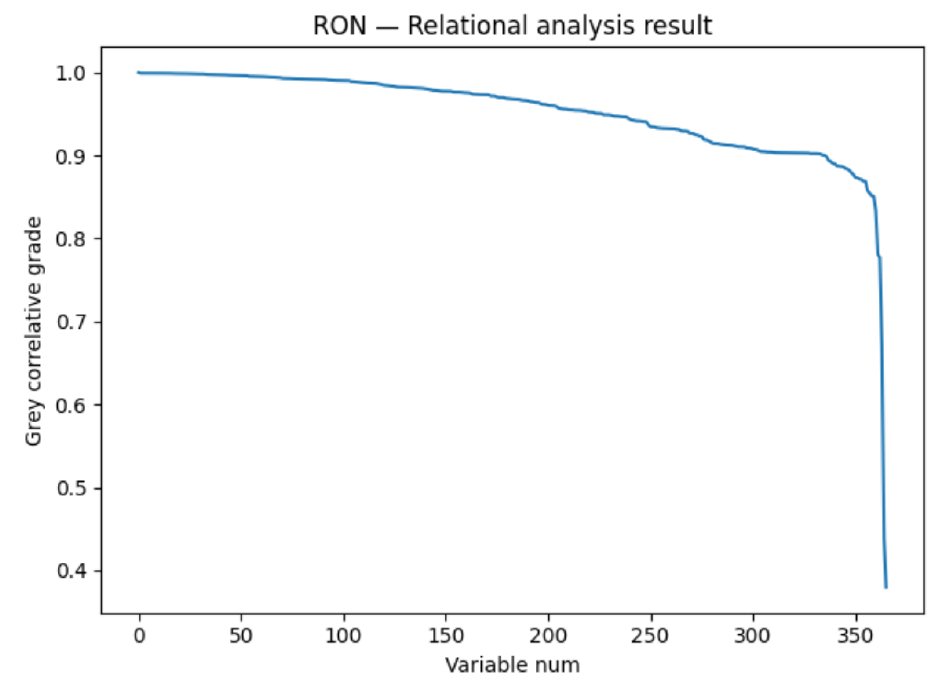
Figure 2. RON grey correlative